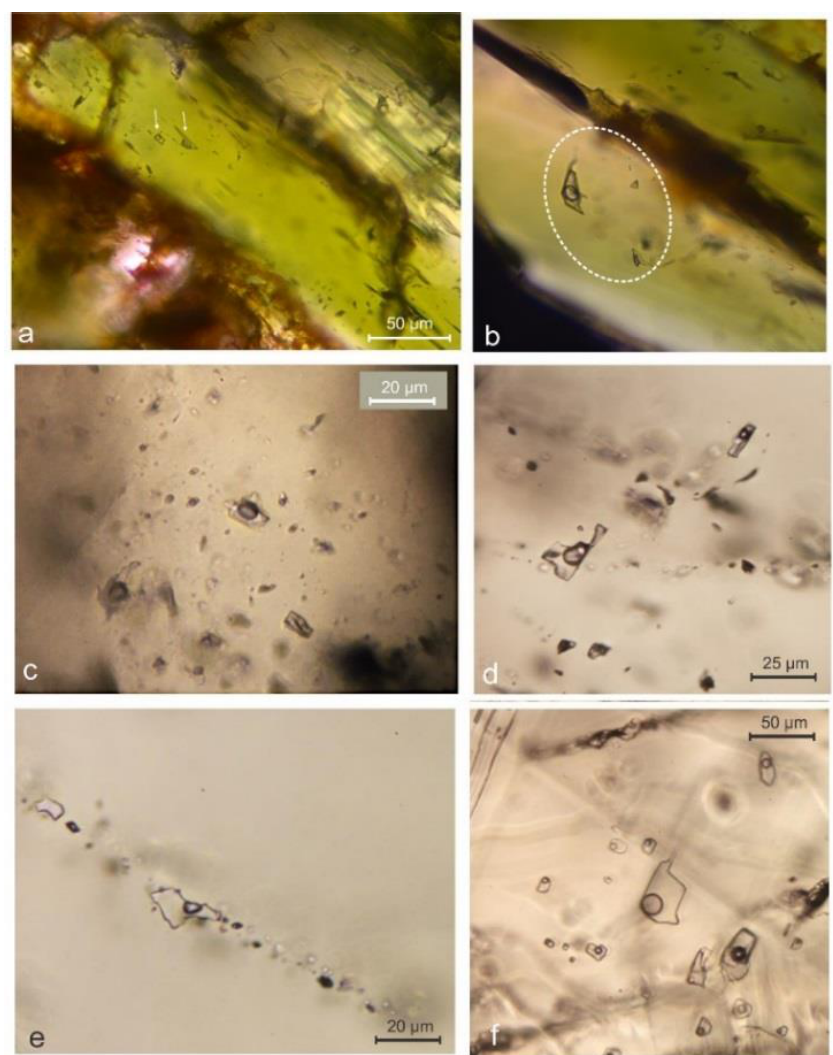
Figure 12. Photomicrographs of fluid inclusions from the Sasa Pb-Zn-Ag skarn deposit; ( a ) Primary two-phase (L and V) fluid inclusions hosted along growth zones of hedenbergite; ( b ) Isolated primary two-phase fluid inclusions in hedenbergite; ( c ) Primary two-phase (L and V) fluid inclusions hosted by retrograde quartz; ( d ) Primary fluid inclusions hosted by syn-ore quartz; ( e ) Trail of secondary fluid inclusions within syn-ore quartz; ( f ) Primary fluid inclusions hosted by post-ore calcite.